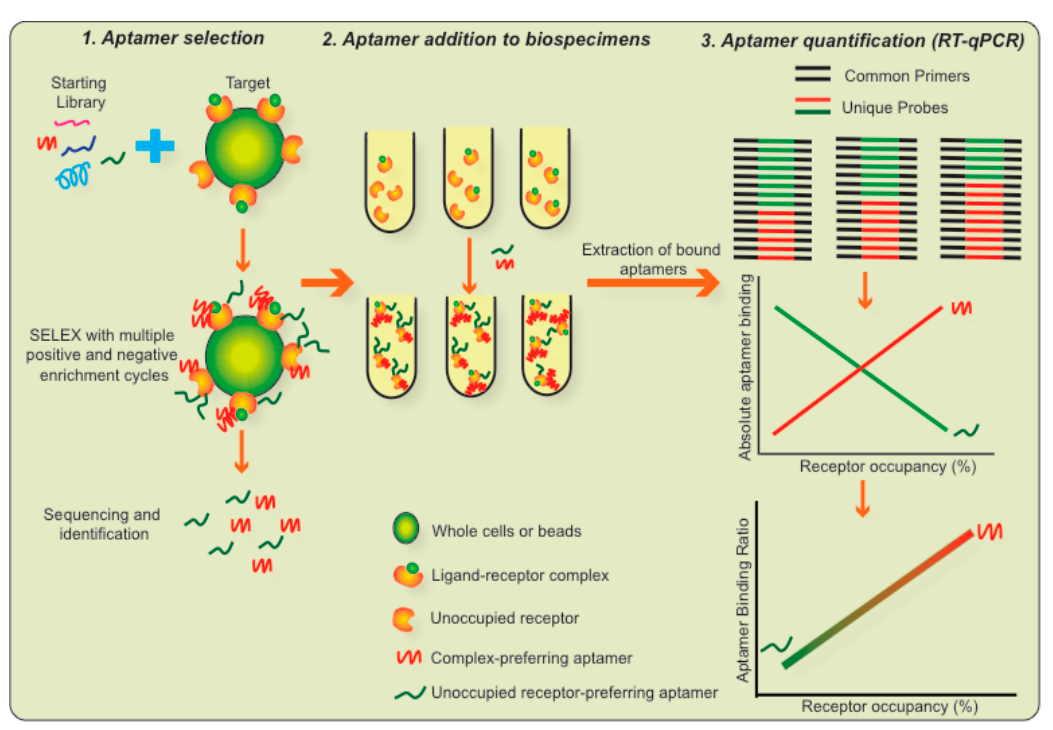
Figure 2. Key steps in the ligand–receptor complex-binding aptamers (LIRECAP) technology for measuring the fractional occupancy of soluble receptors. LIRECAP technology is based on the aptamer pairs that preferentially bind to either the unoccupied receptor or the ligand–receptor complex. When added in equimolar concentration to a given sample, the ratio of binding linearly correlates with the fraction of receptor occupied by the ligand in that sample. Using a standard curve made with samples of known fractional occupancy values, it is possible to calculate the fractional occupancy of the receptor in an unknown sample, such as clinical biospecimens.